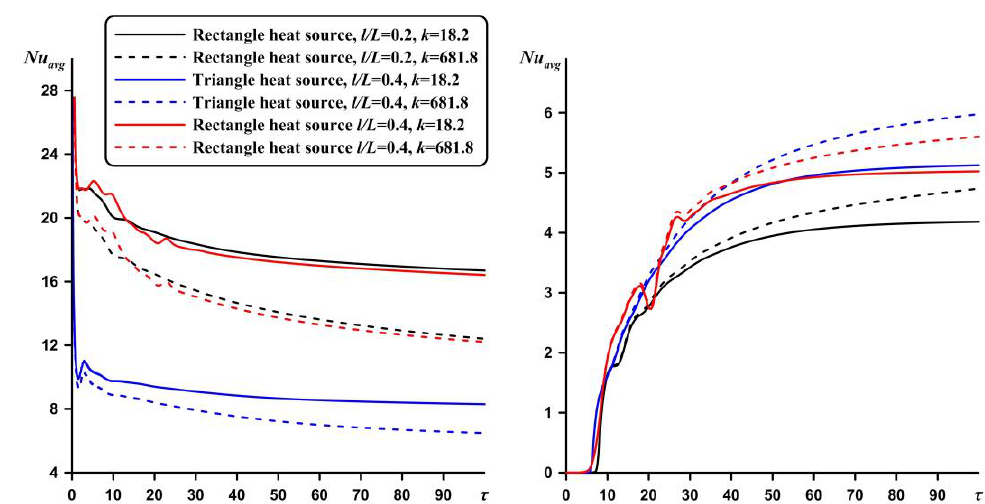
Figure 12. Time profiles of the average Nusselt number at the heater surface for Ra = 10 6 and for different heat source shapes, k and l / L.